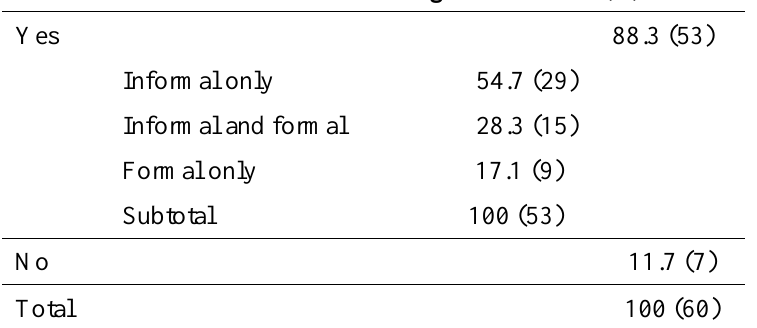
Table 3. Utilization of savings services % ( N